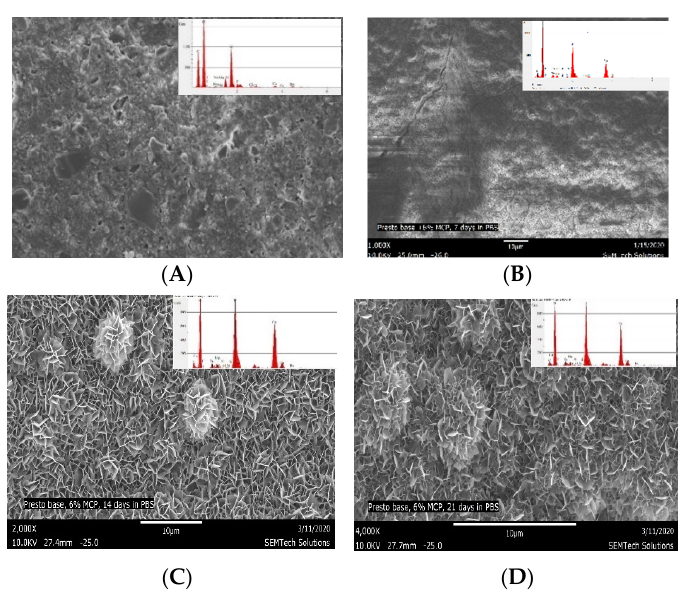
Figure 7. ( A ) SEM micrograph and EDS of the specimen containing 6 wt.% MCP (CS-6) before immersion in PBS; ( B ) after 7 days, ( C ) after 14 days, and ( D ) after 21 days immersion in PBS, showing good surface precipitation of calcium phosphate. The reduced quality of the micrograph of the 7 day specimen may be attributed to the short range order of the amorphous CaP and the accidental inclusion of water (1000×).